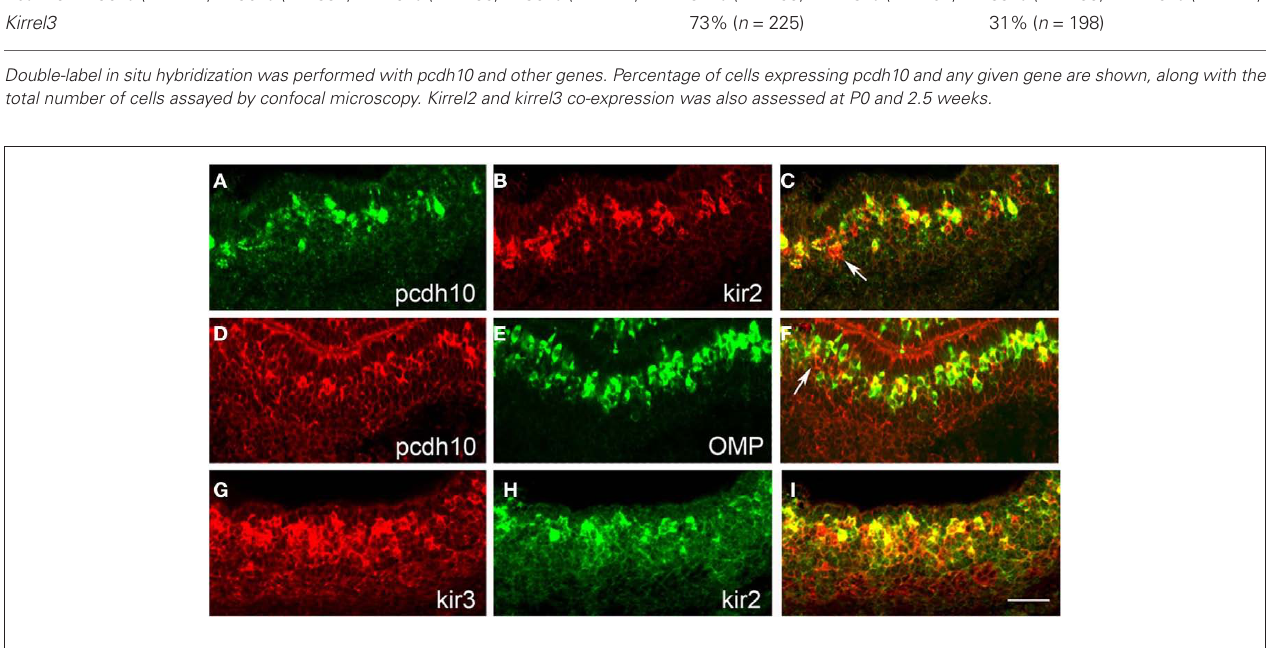
primarily in mature OSNs, although ∼ 10% appear to be present in immature OSNs [white arrow (F) indicates pcdh10 -positive, OMP -negative cell]. (g–i) Double-label in situ hybridization with kirrel3 [ (g) ; red] and kirrel2 [ (H) ; green] at P0 shows significant overlapping expression. Scale bar = 50 μm.